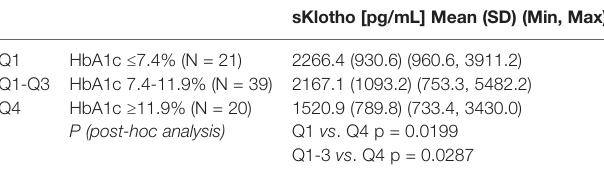
TABLE 5 | Concentrations of sKlotho protein in children with type 1 diabetes according to the degree of metabolic control. sKlotho [pg/mL] Mean (SD) (Min, Max)